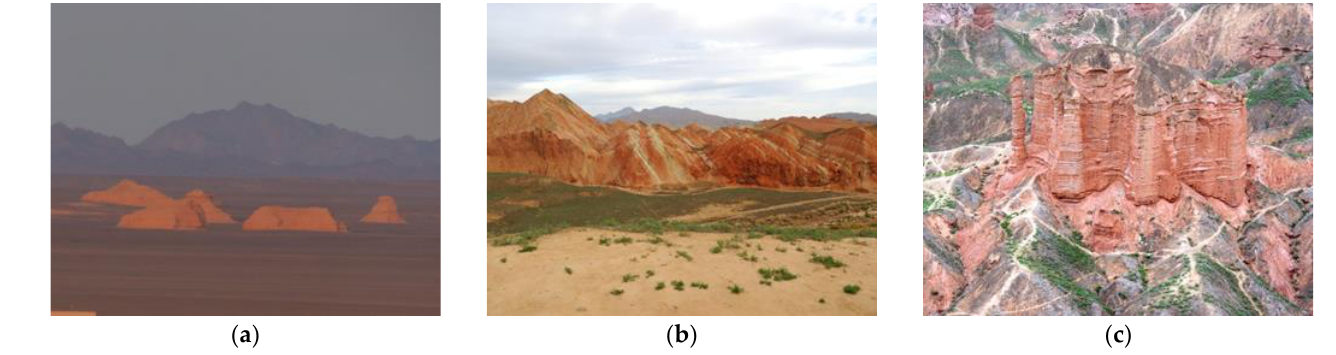
Figure 2. ( a ) Yardang National Geopark (credit Fabio Fratini); ( b ) the Coloured Mountains in the Zhangye Danxia Geopark (credit Fabio Fratini); ( c ) the landscape of the Ice Gullies with peaks and tabular forms (credit Loredana Luvidi) .